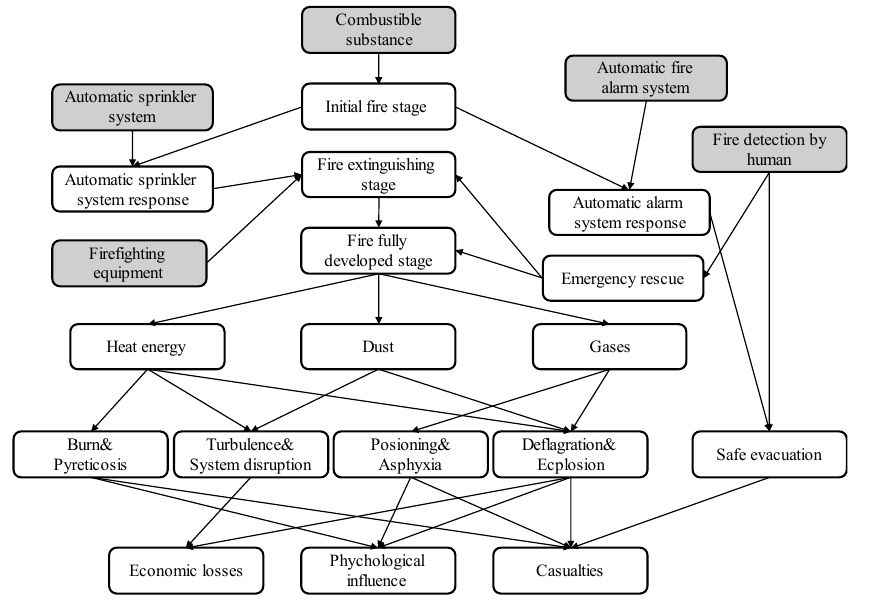
Figure 6. DAG of UEF. Table 1. Description and states of Bayesian nodes.